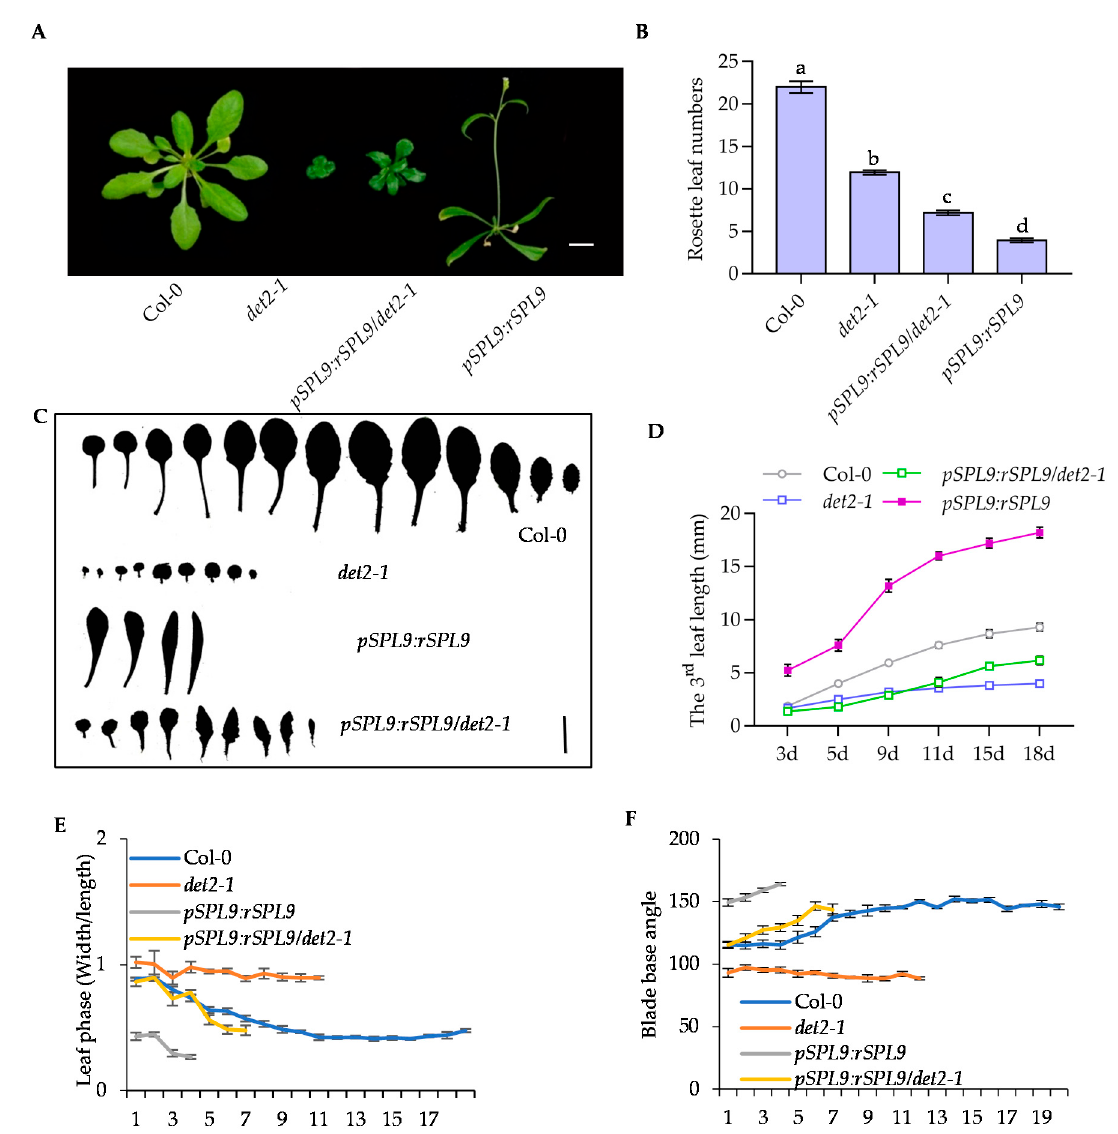
Figure 5. The pSPL9:rSPL9 suppressed the delayed vegetative phase change of det2-1 mutant. ( A ) The growth phenotype of 5-week-old wild type, det2-1 , pSPL9:rSPL9 and pSPL9:rSPL9 / det2-1 plants. ( B ) The rosette leaf numbers of wild type, det2-1 , pSPL9:rSPL9 and pSPL9:rSPL9 / det2-1 after flowering. Error bars represent standard deviation ( n = 10). Different letters above the bars indicated statistically significant differences between the samples (ANOVA analysis followed by Uncorrected Fisher’s LSD multiple comparisons test, p < 0.05). ( C ) The shape phenotypes of full expanded rosette leaves of wild type, det2-1 , pSPL9:rSPL9 and pSPL9:rSPL9 / det2-1 . ( D ) The 3rd leaf length of wild type, det2-1 , pSPL9:rSPL9 and pSPL9:rSPL9 / det2-1 after initiation different days. The leaf lengths were measure from at least 30 plants. Error bars represent standard deviation. ( E ) The ratio of leaf width to leaf length of full expanded rosette leaves of wild type and indicated plants. The leaf width and leaf length were measure from at least 30 plants. Error bars represent standard deviation. ( F ) The base angle of full expanded rosette leaves of wild type and indicated plants. The leaf base angle were measure from at least 30 plants. Error bars represent standard